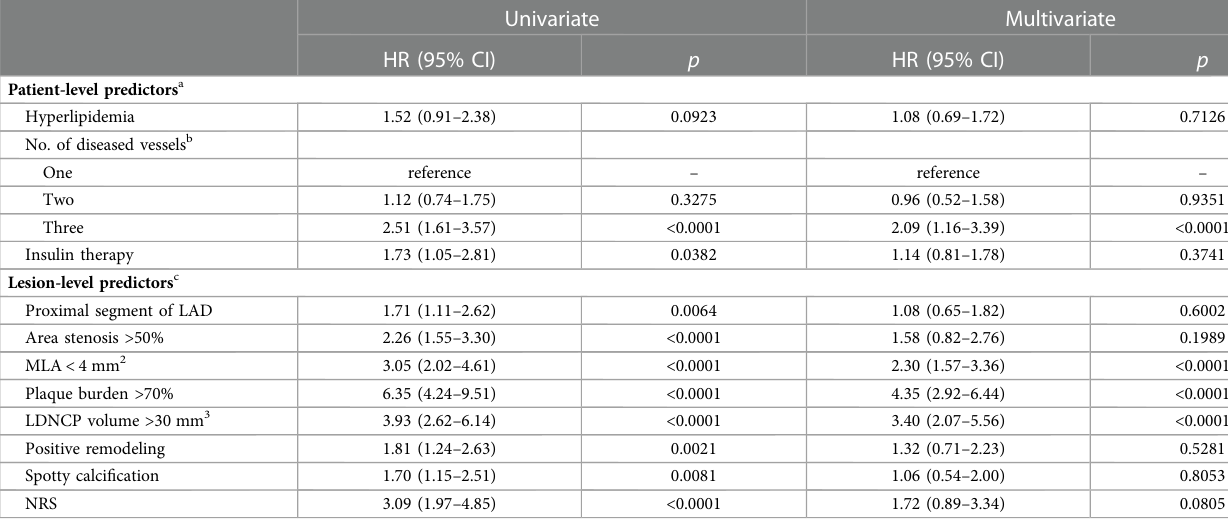
TABLE 4 Univariate and multivariate analyses for predictors of NCL-related